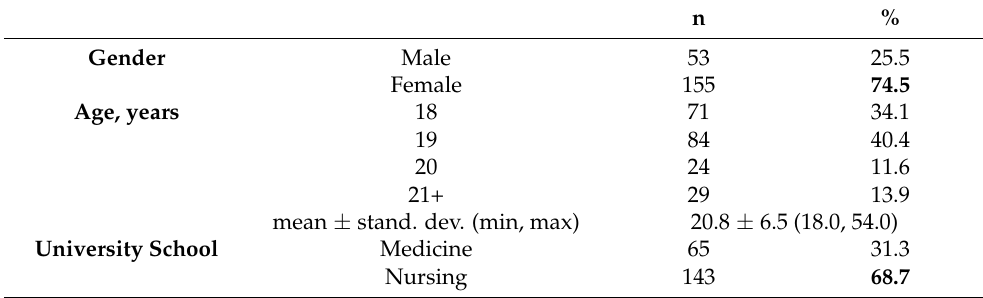
Table 1. Demographic characteristics of the 208 participants.